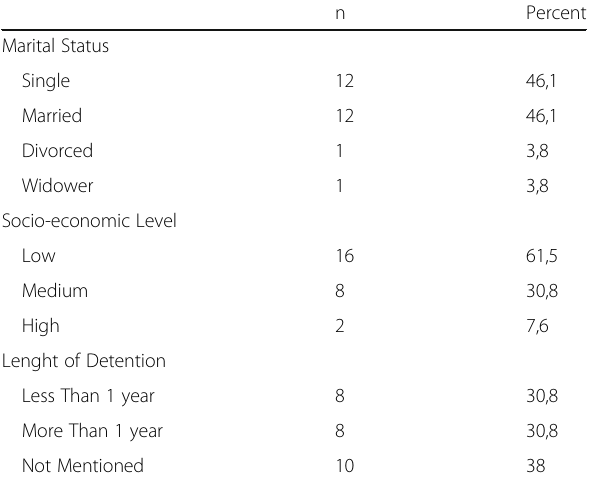
Table 1 The characteristics of the